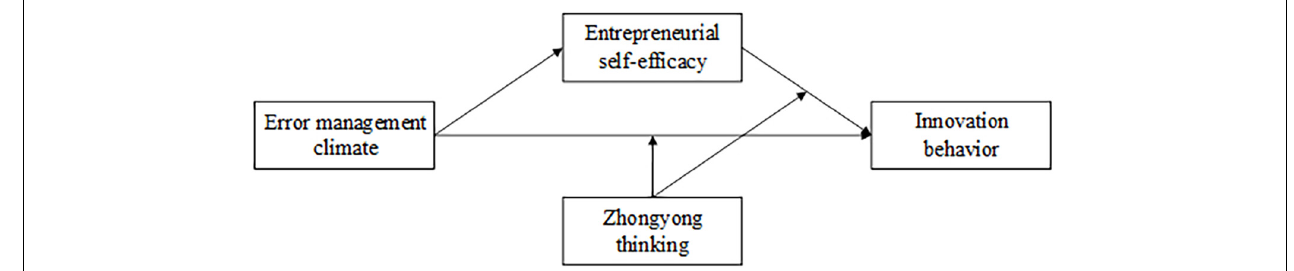
FIGURE 1 | Research framework.